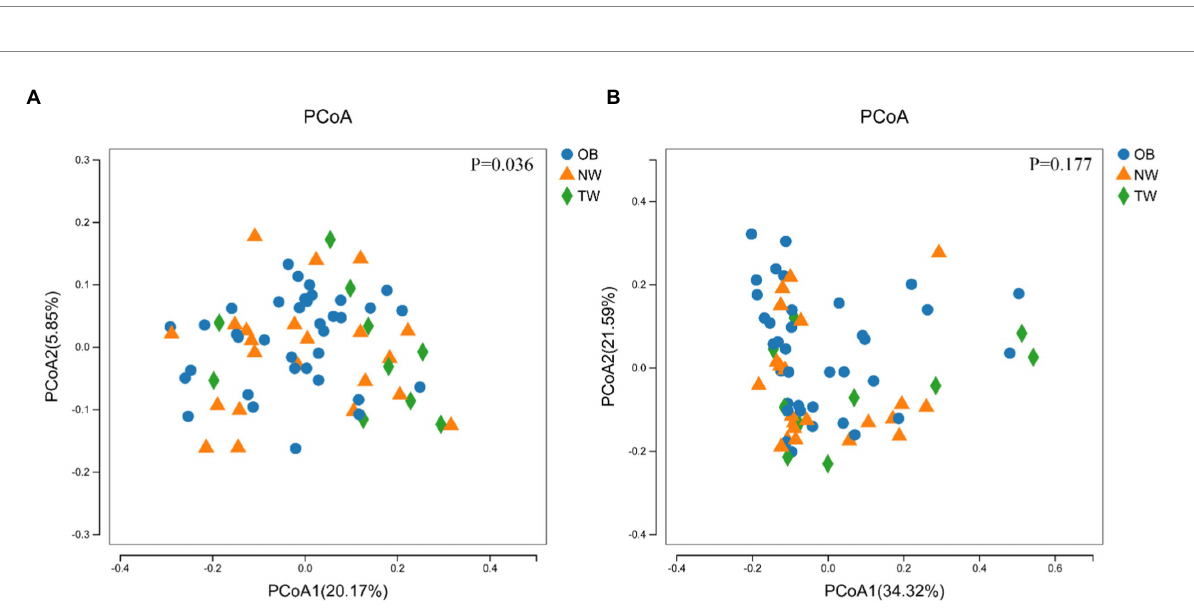
FIGURE 4 PCoA of three groups. (A) PCoA with weighted species taxonomic abundance information; (B) PCoA without weighted species taxonomic abundance information. The value of ps are shown above the boxes. In statistics, PERMANOVA was used to test for significant differences in